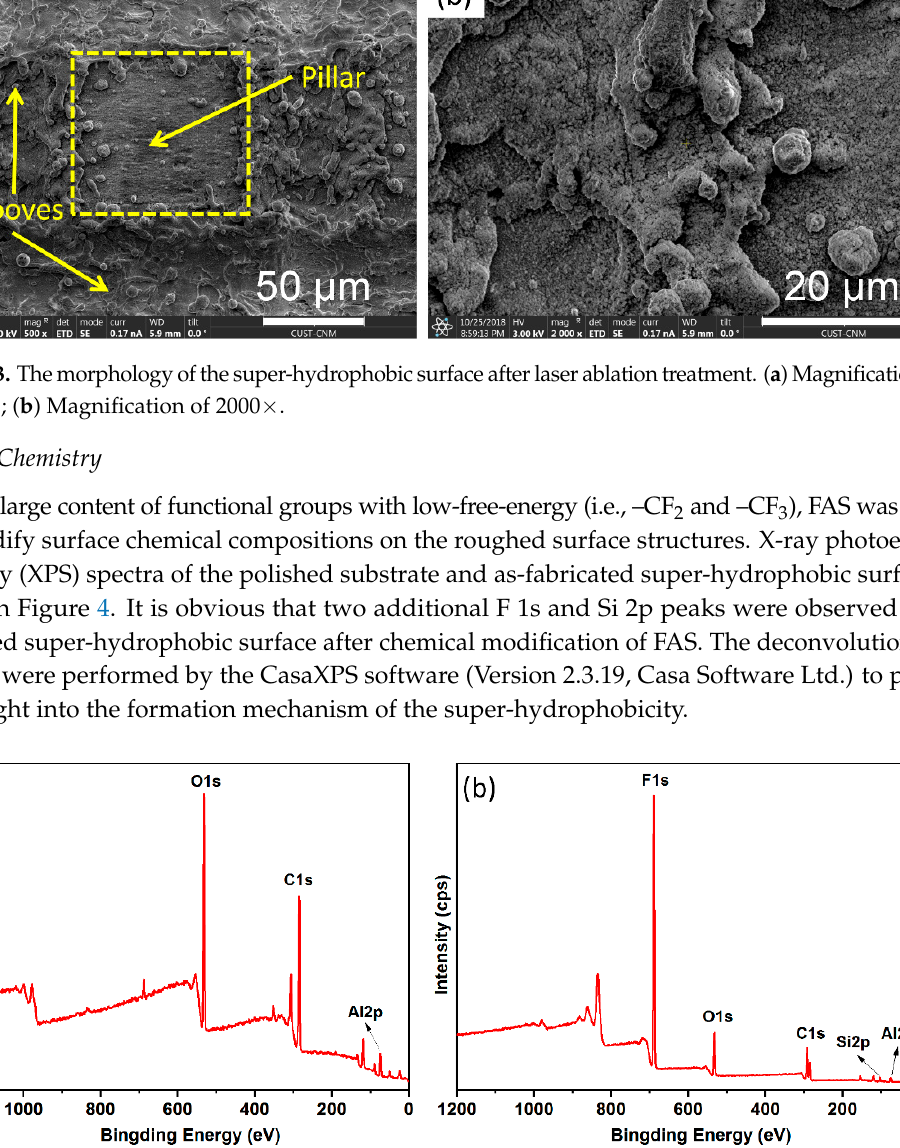
Figure 4. XPS survey spectra of ( a ) polished aluminum alloy and ( b ) as-prepared super-hydrophobic surface.